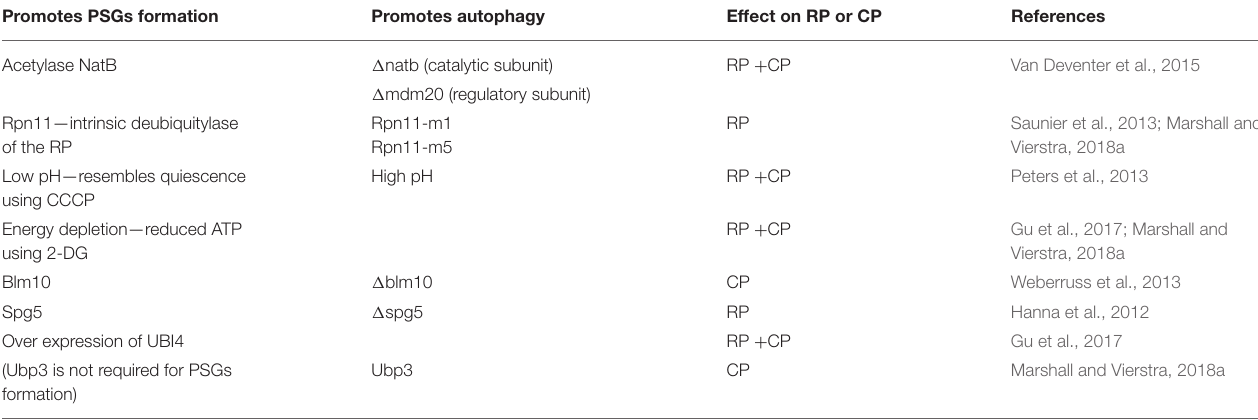
TABLE 1 | Conditions that impact PSGs formation inversely affect